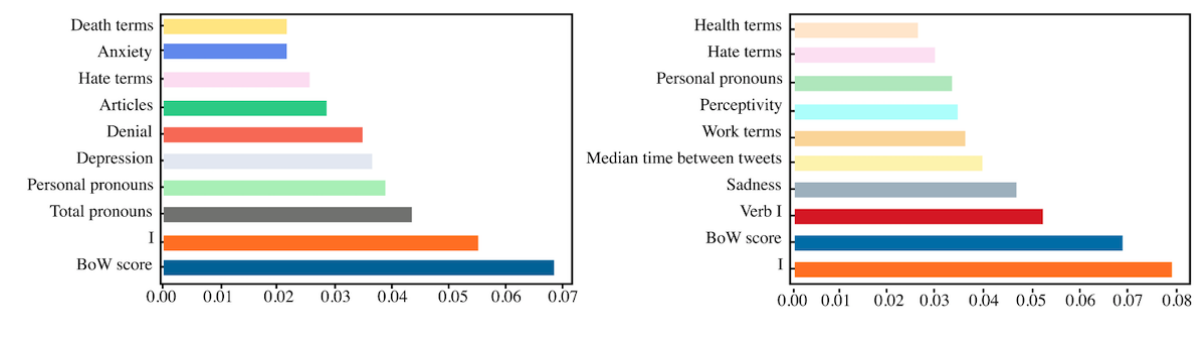
Figure 2. Most predictive features for both tasks: Suicidal ideation risk vs Focused control (left), and Suicidal ideation risk vs Generic control